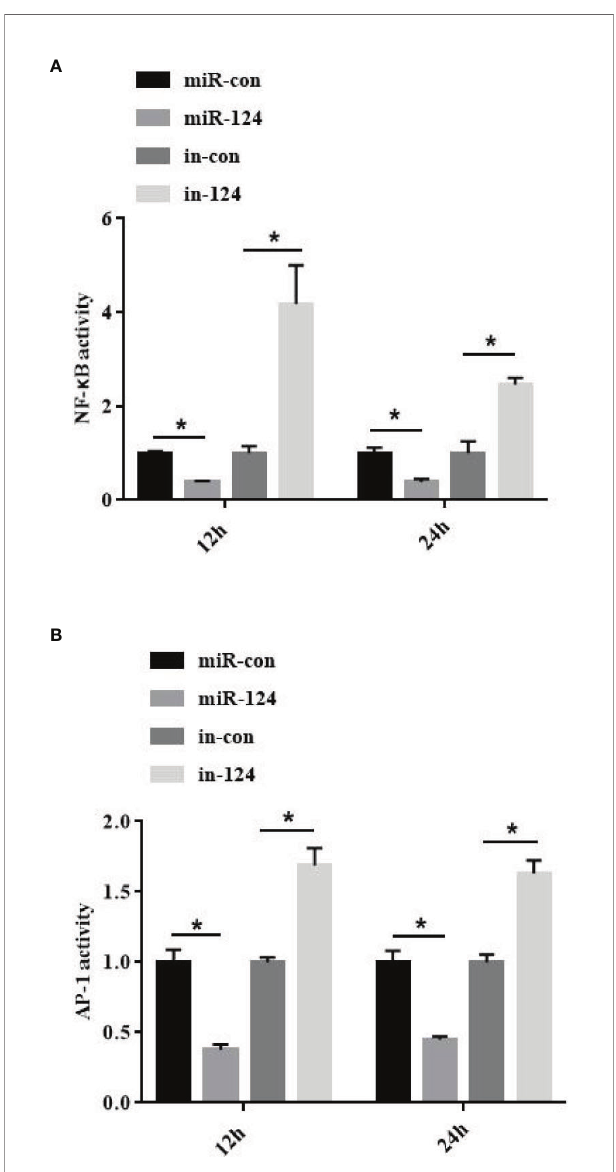
FIGURE 6 | MiR-124 inhibited NF- k B and activating protein-1 (AP-1) activation. The activities of NF- k B (A) and AP-1 (B) were analyzed by dual luciferase reporter assays. The miRNAs were transfected into the fathead minnow (FHM) cells in 24-well plates. After 24-h transfection, cells were infected with Singapore grouper iridovirus (SGIV) for 12 and 24 h. Relative luciferase activity is measured as a ratio of fi re fl y luciferase activity to Renilla luciferase activity. Control mimics, miR-con; miR-124 mimics, miR-124; control inhibitors, in-con; miR-124 inhibitors, in-124. All data are presented as mean ± SD, N = 4. Compared with the control group, signi fi cant difference of experimental group is indicated with *( P <